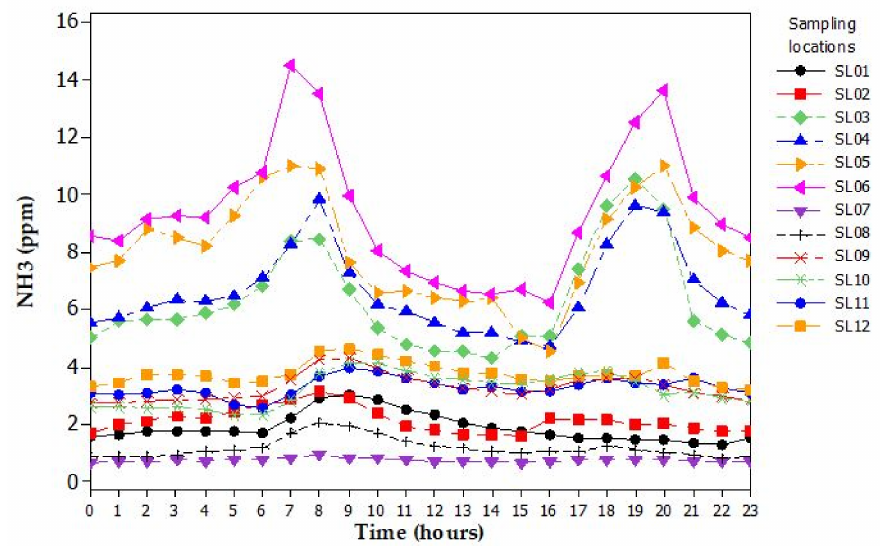
Figure 3. Diurnal variation of ammonia (NH 3 ) based on mean values of gas concentrations computed during the observation periods.